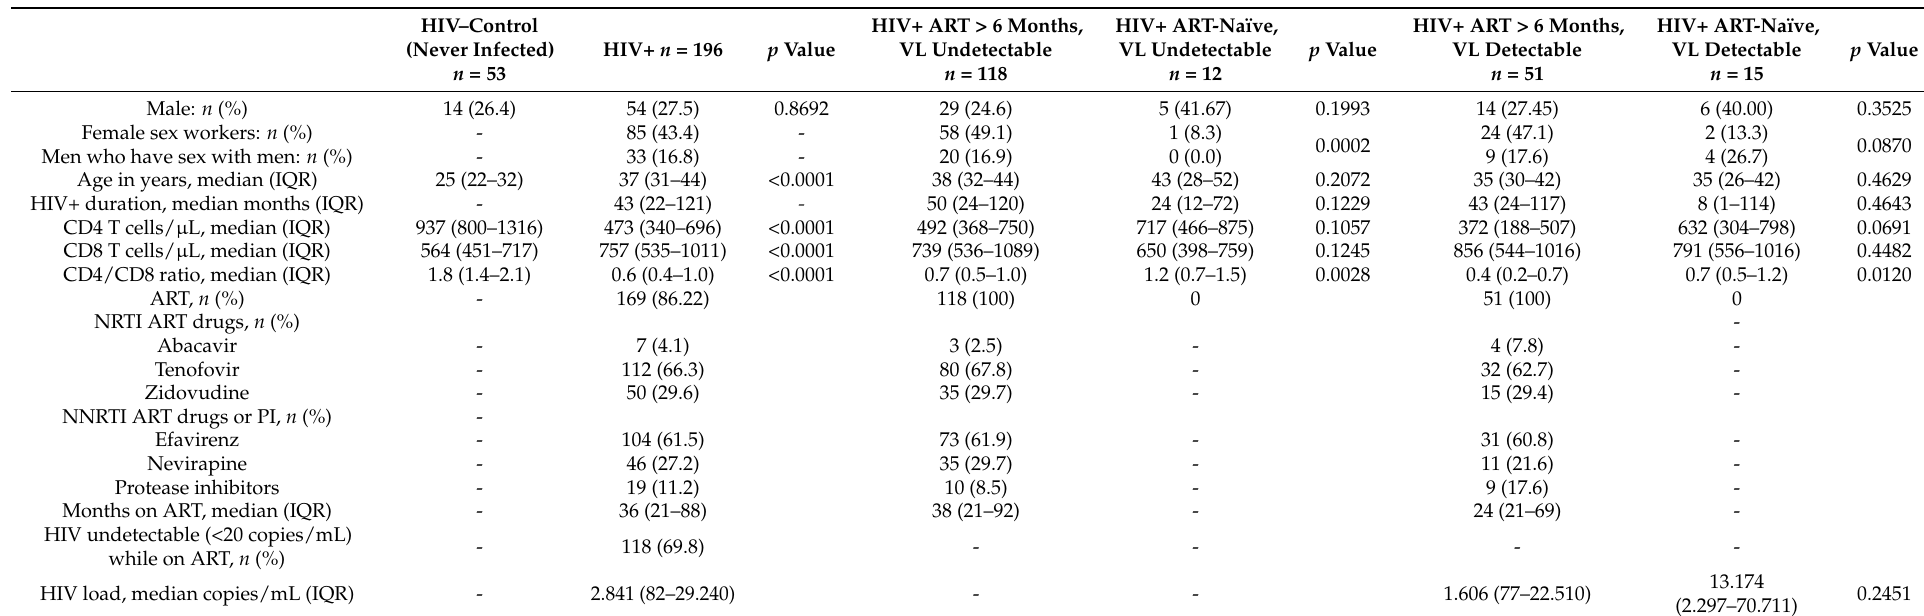
Table 1. Characteristics of the study